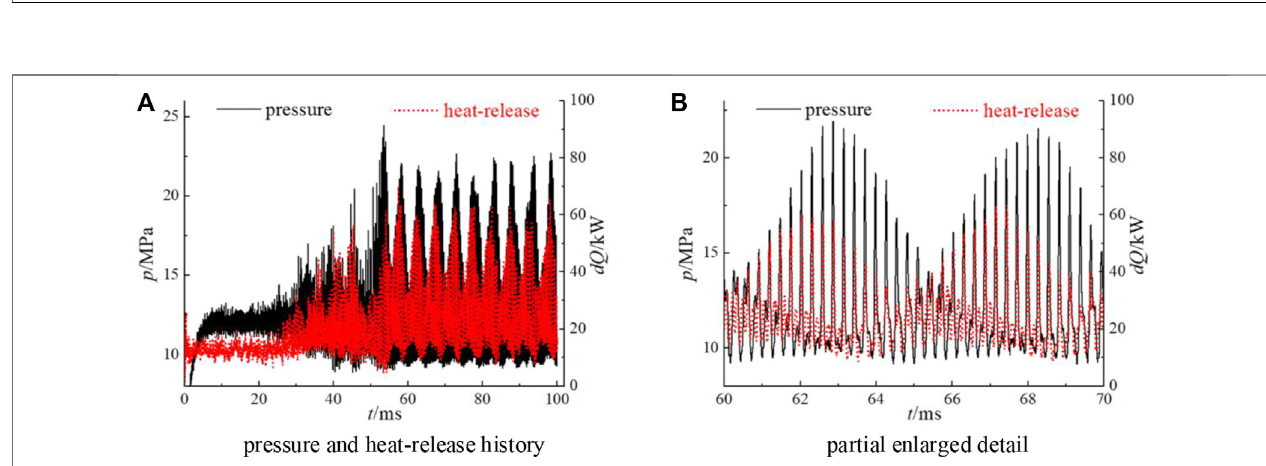
FIGURE 8 | Pressure and heat-release changing process within half a period in case2. (A) Pressure contours within half a cycle. (B) Heat-release contours within half a cycle.